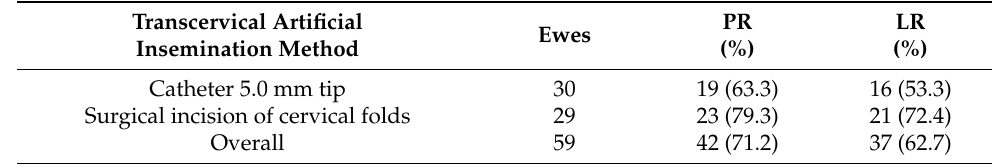
Table 4. Pregnancy (PR) and lambing (LR) rates of ewes inseminated with two different methods for transcervical artificial insemination